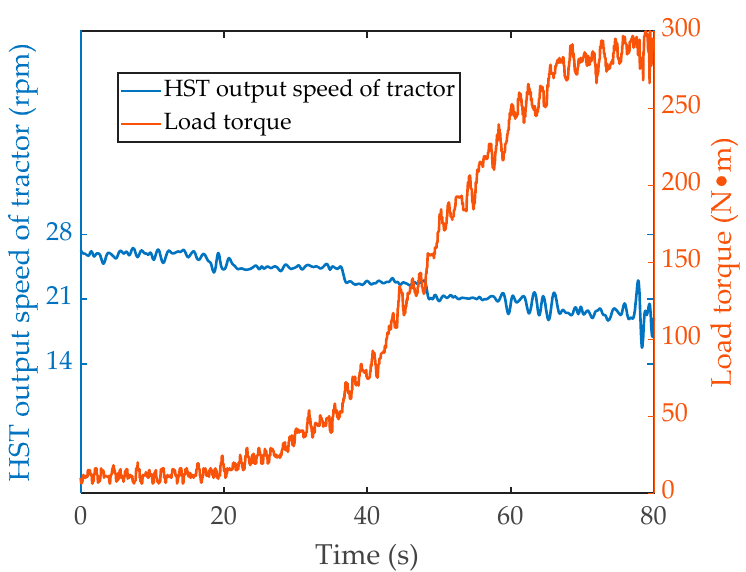
Figure 13. Variation curve of the system response and load in the open-loop control.